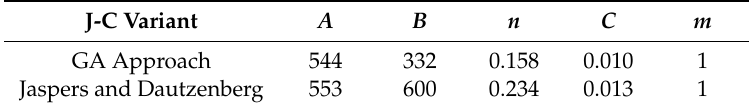
Table 2. J-C parameters fitted using Genetic algorithm (GA) approach and Jaspers and Dautzenberg reported values.